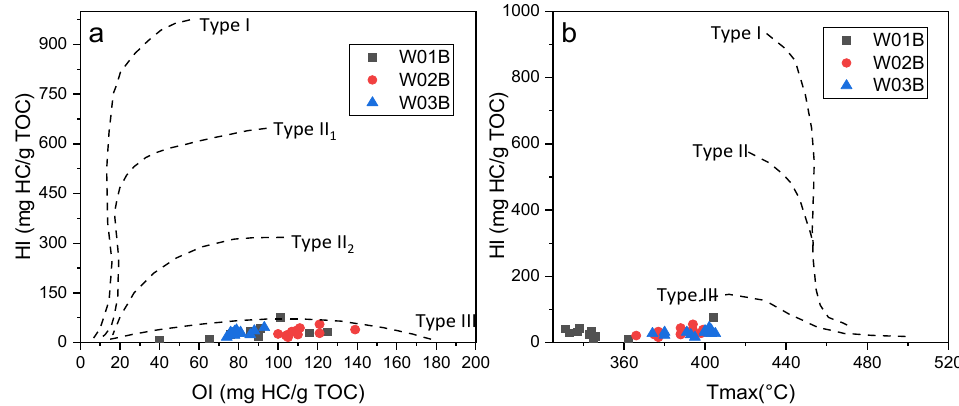
Figure 7. ( a ) Diagram of Rock-Eval HI vs. OI; ( b ) plot of HI vs. T max of sediment samples from W01B, W02B, and W03B.